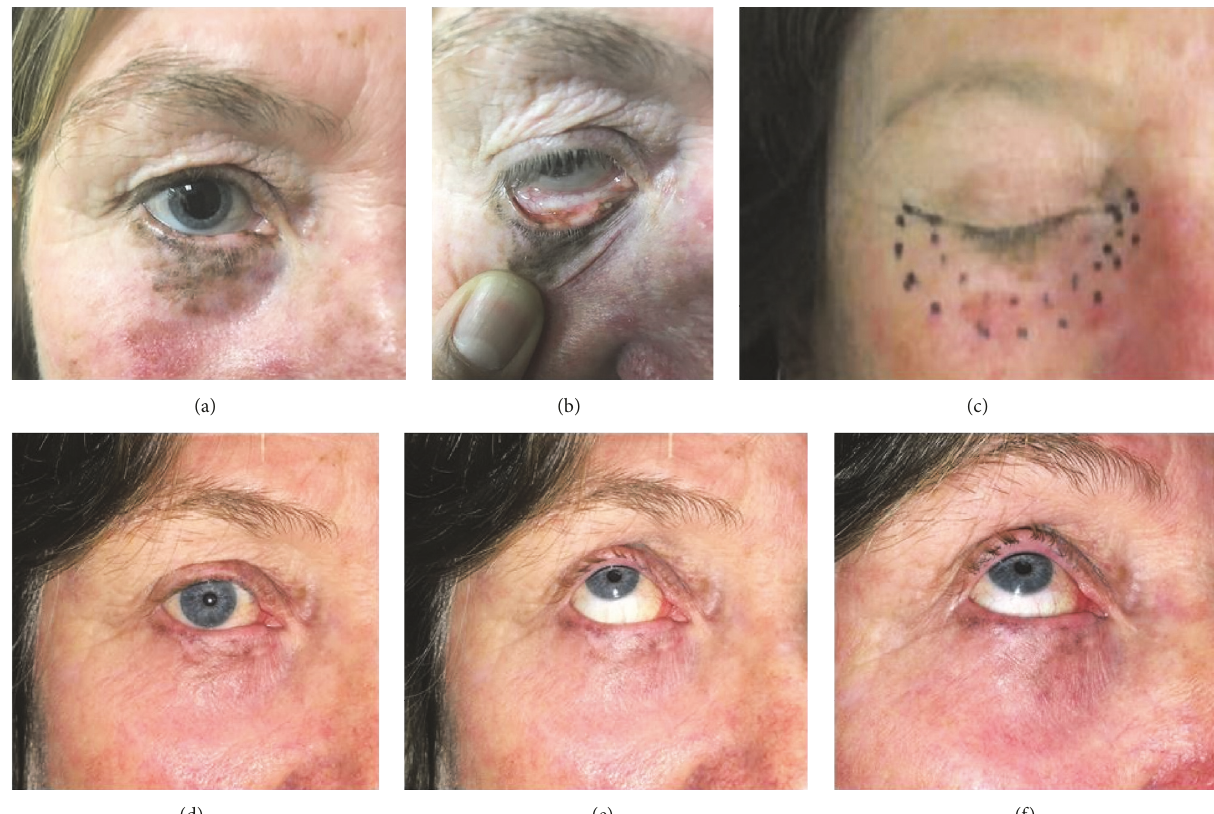
Figure 14: (a, b) This lady had a significant pigmented lentigo maligna of the lower right eyelid. It spilt over onto the palpebral surface of the conjunctiva. (c) The next figure shows the CTV as marked by the radiation oncologist and then a 5 mm expansion to superficial radiotherapy field. (d, e, f) The following three images are photos taken six weeks after treatment. One can see significant resolution of the lentigo maligna and loss of the lower lid eyelashes but the globe is untouched. Eye and vision are fine as at